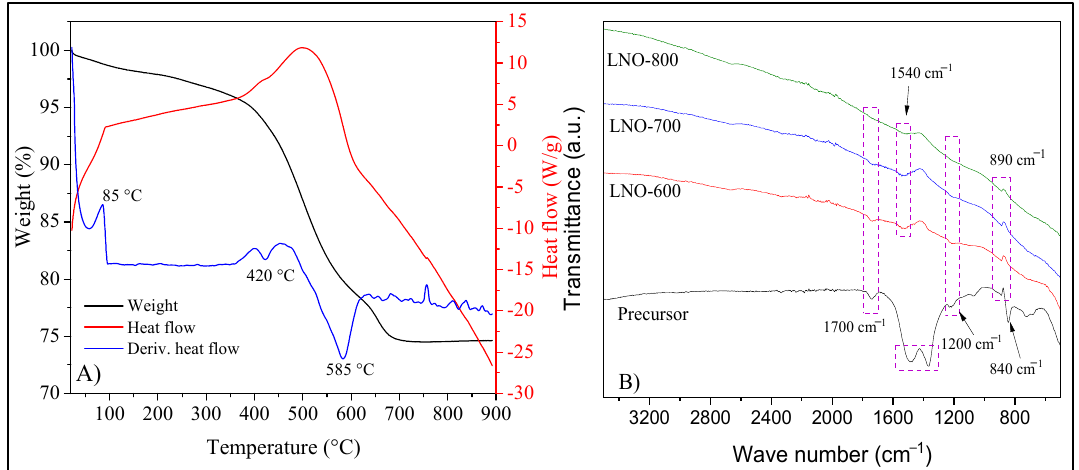
Figure 5. TG and DT dynamic analyses of precursor powders in an N 2 atmosphere ( A ) and ATR-FTIR spectra of LaNiO 3 samples calcined at different temperatures ( B ).